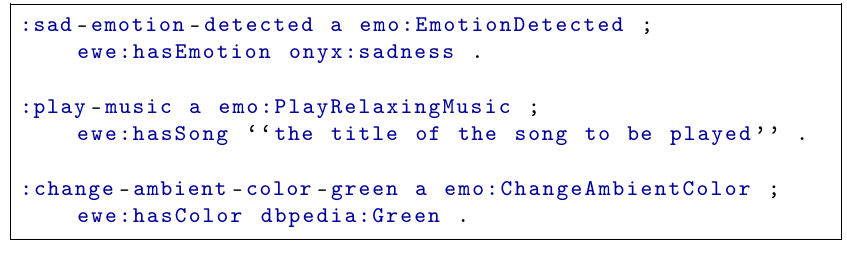
Table 2. Event and action instances.